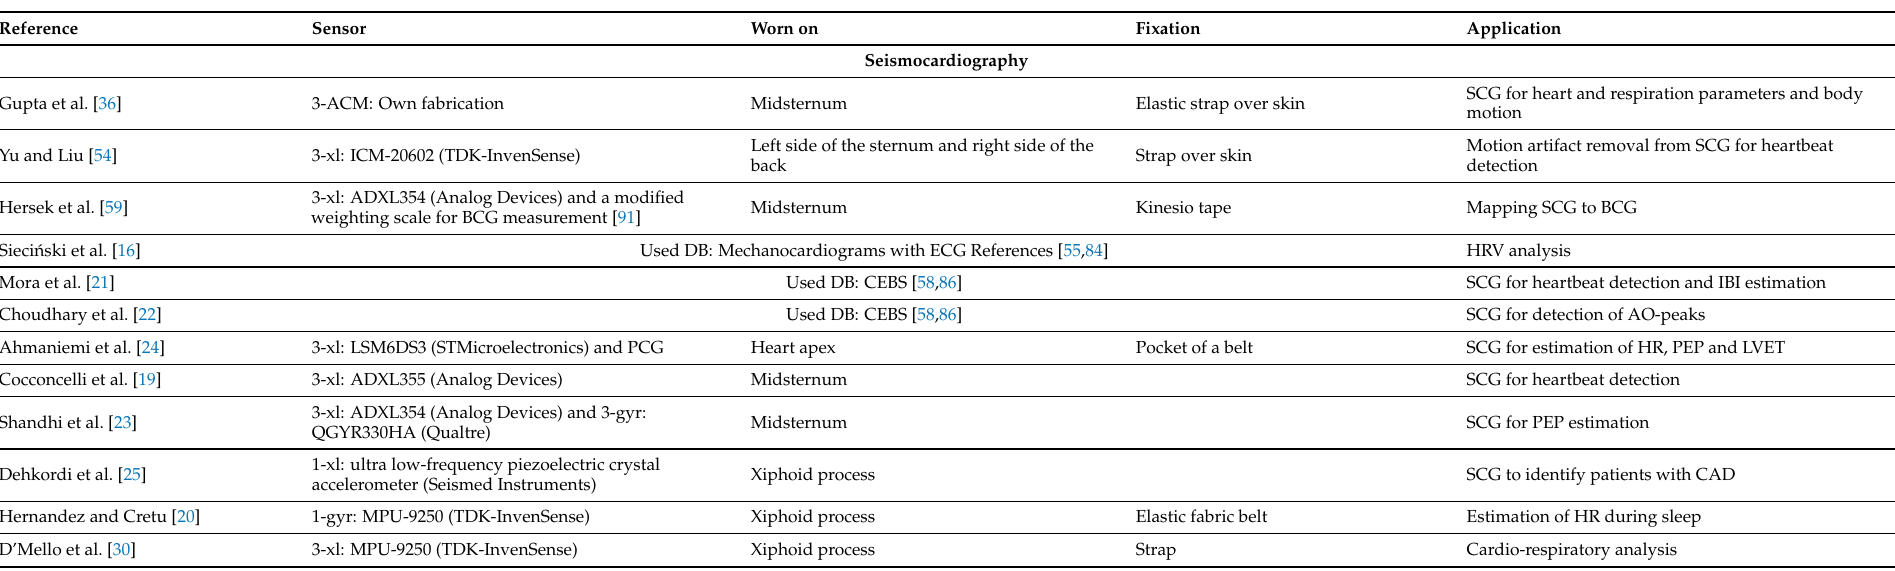
Table A1. List of the referenced studies with their applications and measurement methods. Preceding numbers in “Sensor” column reveal degree of